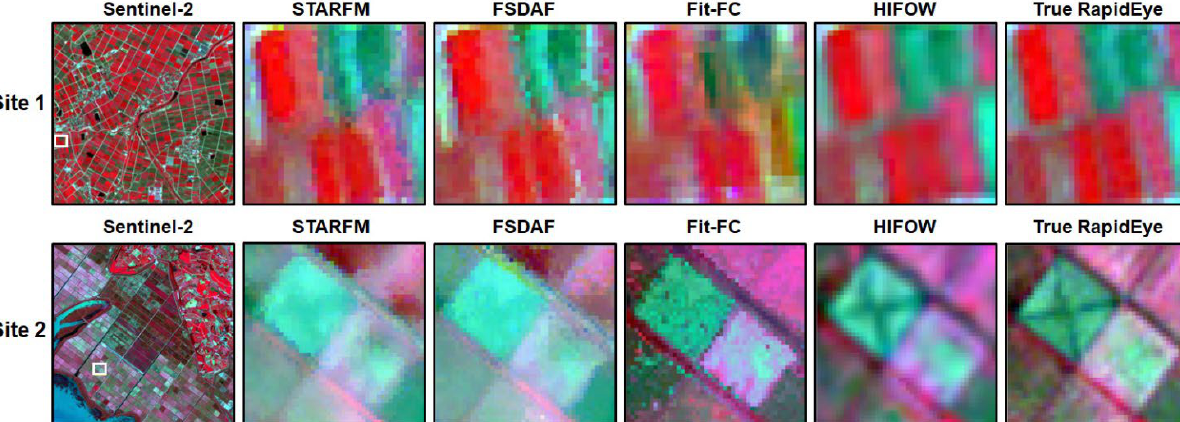
Figure 8. Prediction results of different STIF models with Sentinel-2 and RapidEye images in the zoomed-in sub-areas at the two sites. The sub-area marked with a white box in the Sentinel-2 imagery is enlarged. All color composite images are displayed with NIR-red-green as RGB.